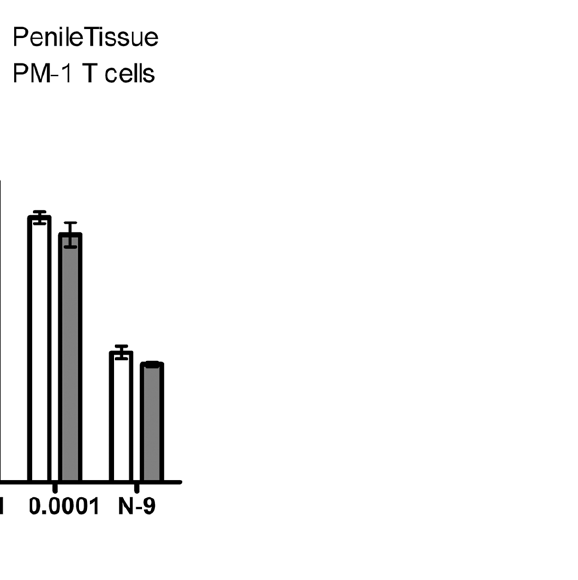
Figure 2. Viability assay to evaluate the cytotoxicity of M48U1 on mucosal tissue explants and PM-1 T cells. Penile tissue explants (blank bars) and PM-1 cells (grey bars) were exposed to 10-fold dilutions of M48U1 for 24 h at 37 u C. After removing the peptide, the tissue explants and the cells were incubated with MTT for 2 h. Then the viability was determined by measuring the formazan release. Nonoxynol-9 microbicide (500 ng/mL) was employed as cytotoxic reference, while the untreated control was assumed as 100% of viability. Data points correspond to mean values and error bars represent the standard error of the mean (SEM) from two independent experiments performed in triplicates.